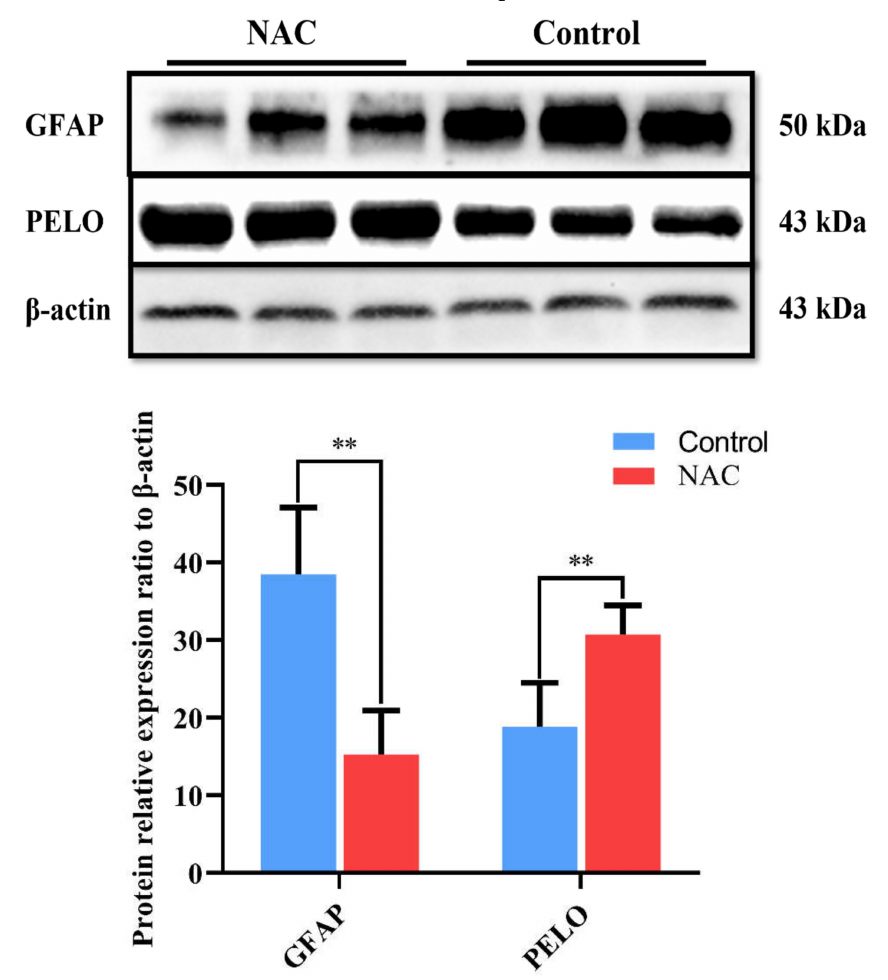
Figure 7. Effects of NAC on the protein expression of GFAP and PELO in the uteri of Qianbei- pockmarked goats. GFAP, glial fibrillary acidic protein; PELO, pelota mRNA surveillance and ribosomal rescue factor; ** indicates highly significant difference ( p <